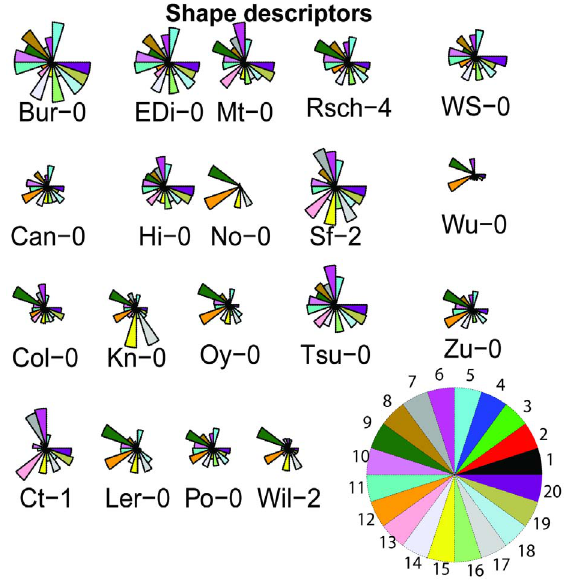
Figure 5. Shape descriptor plots of ecotype’s feature profile. Radar plot of 20 shape features for each ecotype. Plots are average of 12 replicates over five time points. Variable assignment key for star plot is located at the bottom right corner. Each star plot or segment diagram represents one row of the input data. Variables (columns) start on the right and wind counter clockwise around the circle. The size of the (scaled) column is shown by the distance from the centre to the point on the star or the radius of the segment representing the variable. The columns of the data matrix are scaled independently so that the maximum value in each column is 1 and the minimum is 0. Segment numbers corresponding to descriptors are defined in Table 1.